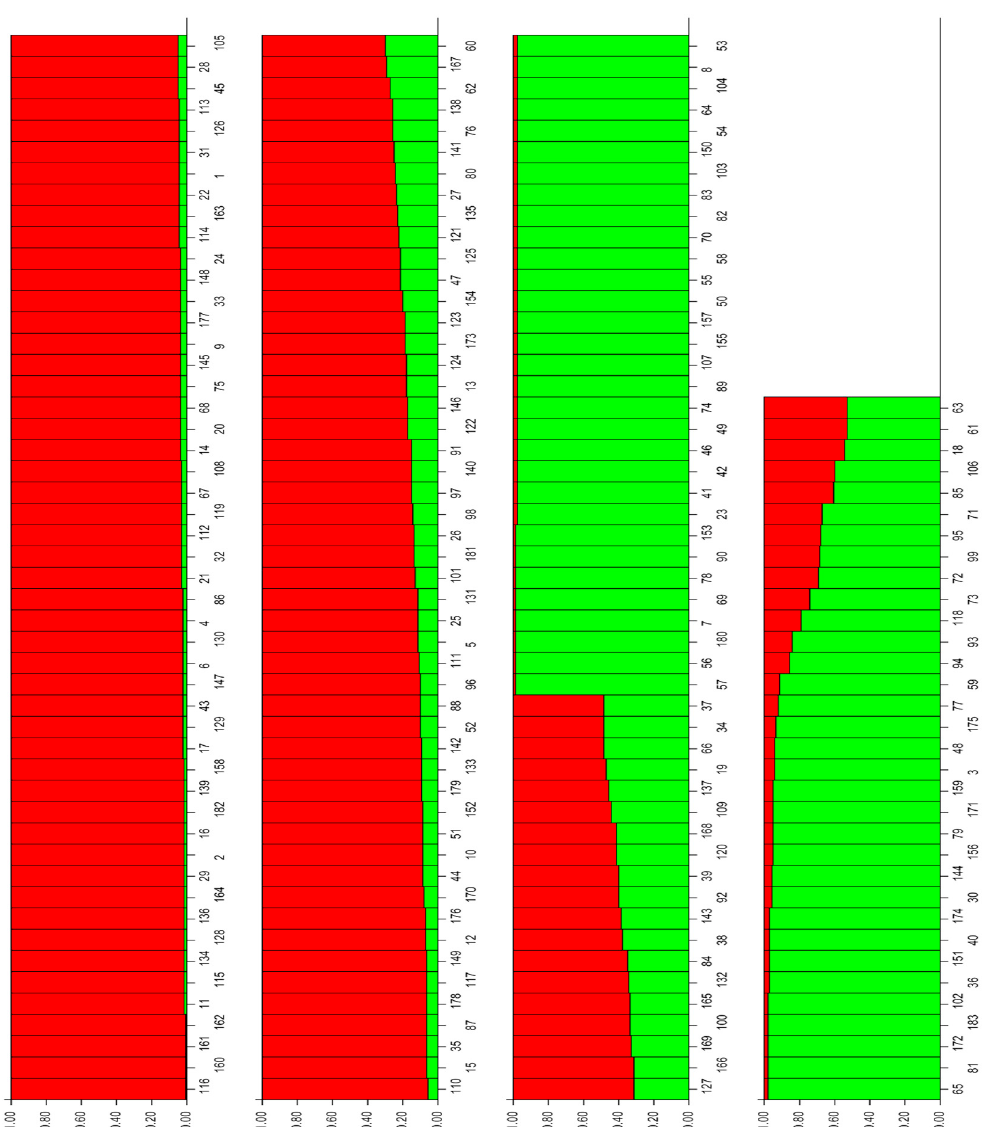
Figure 5. Inference of population structure based on microsatellite data and Bayesian simulation.